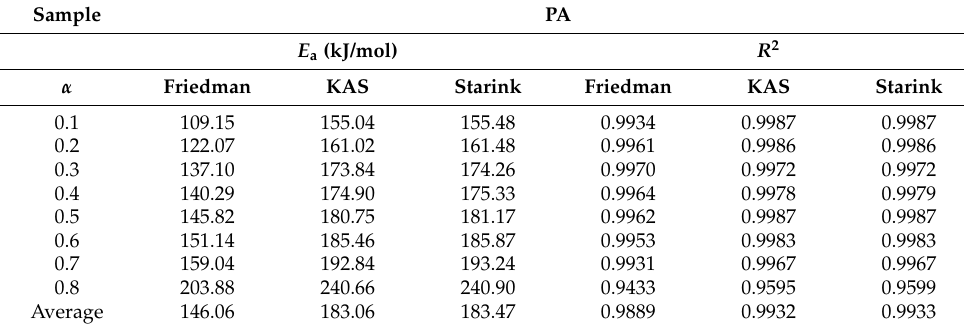
Figure 8. Calculation of E a from TG curves for PA and PA-T152 using Vyazovkin model. Table 3. Calorimetric data from dynamic scanning experiments of PA. Table 3. Thermogravimetric loss data for PA.